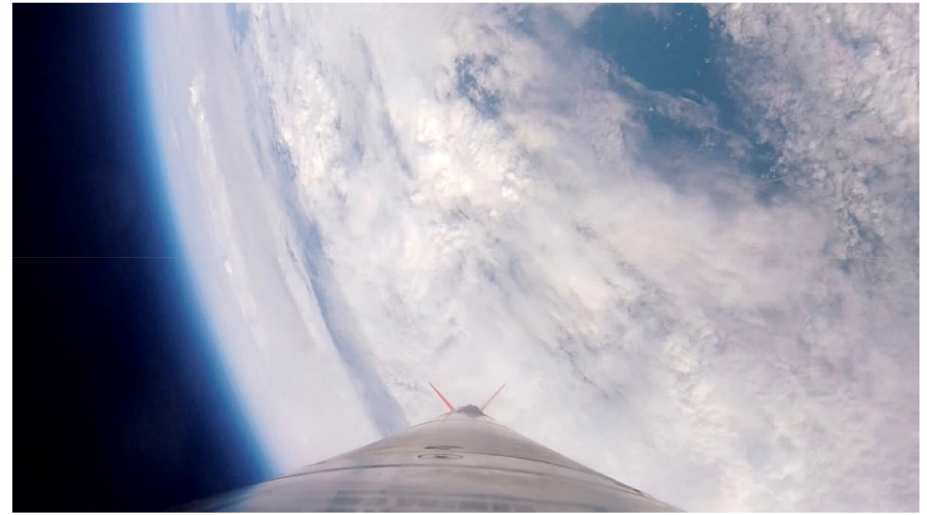
Figure 13. View from one of the on-board cameras of the ILR-33 AMBER rocket at 23 km